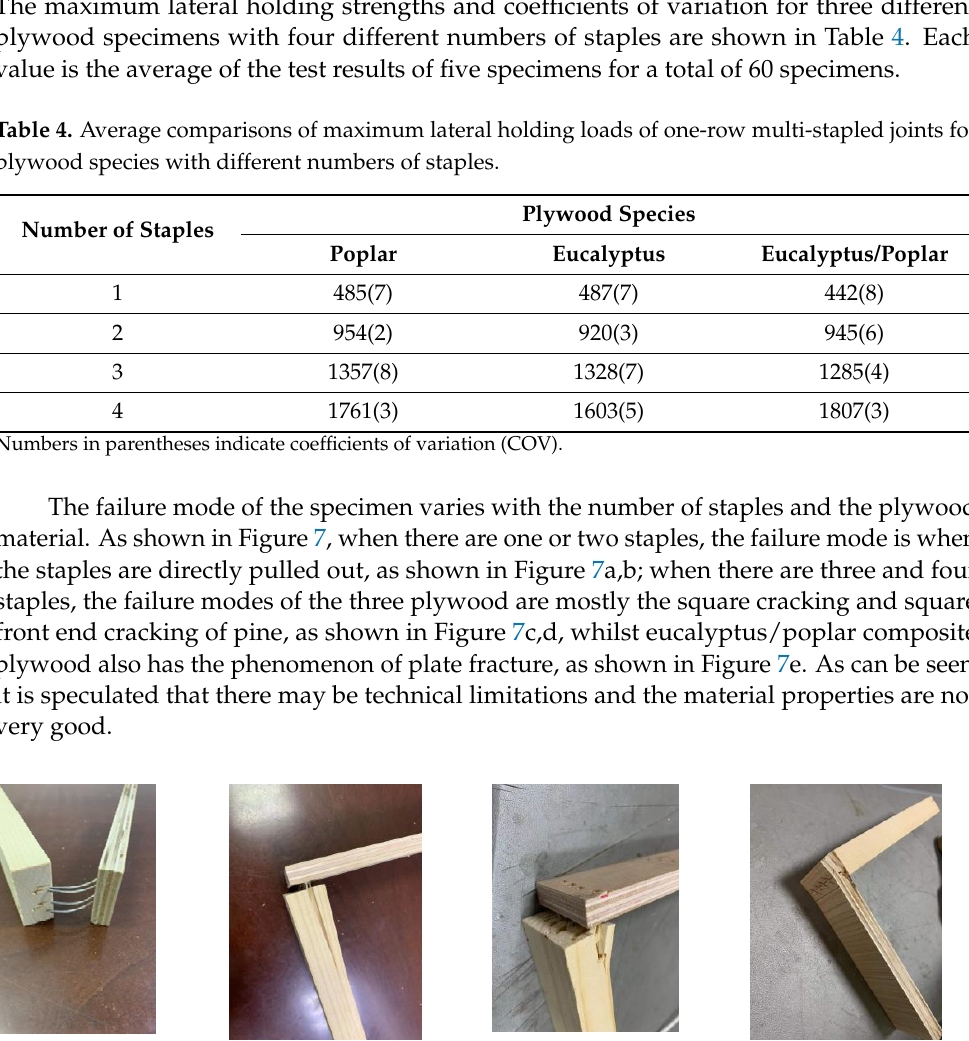
Table 3. Constants K 1 , r 2 and p values in the prediction equation for the average maximum with- drawal loads of one-row multi-stapled joints composed of three different plywood types.